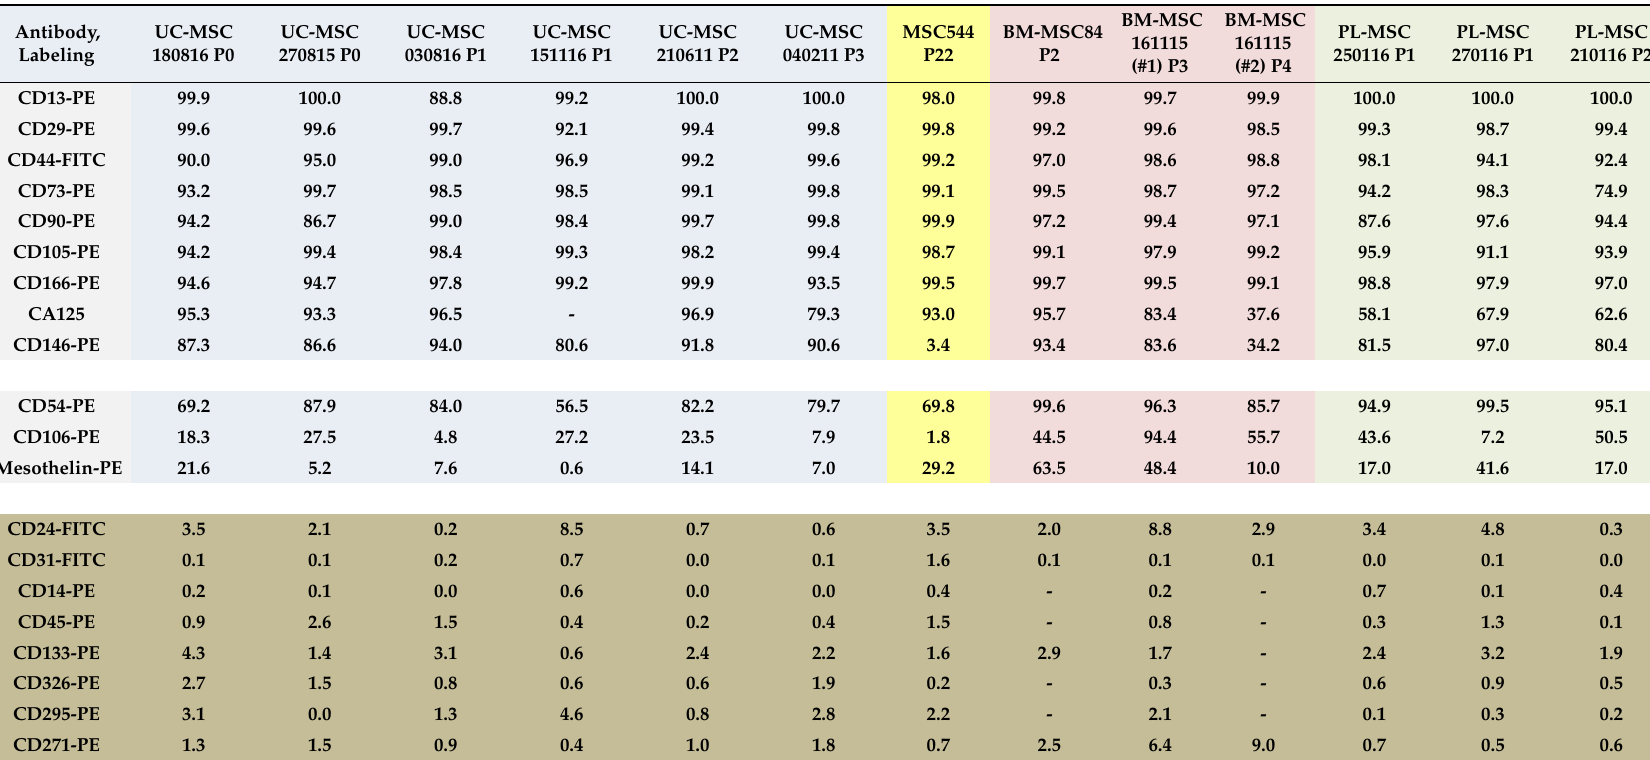
Table 1. Flow cytometry analysis of various expression markers was performed in 12 di ff erent human MSC populations, six derived from umbilical cord (UC) in passage (P) 0 to P3 (blue background), three from bone marrow (BM) in P2 to P4 (red background), three from placenta (PL) (green background) in P1 to P2, and compared to MSC544 in P22 (yellow background). Proteins at low to undetectable levels are displayed by a khaki-colored